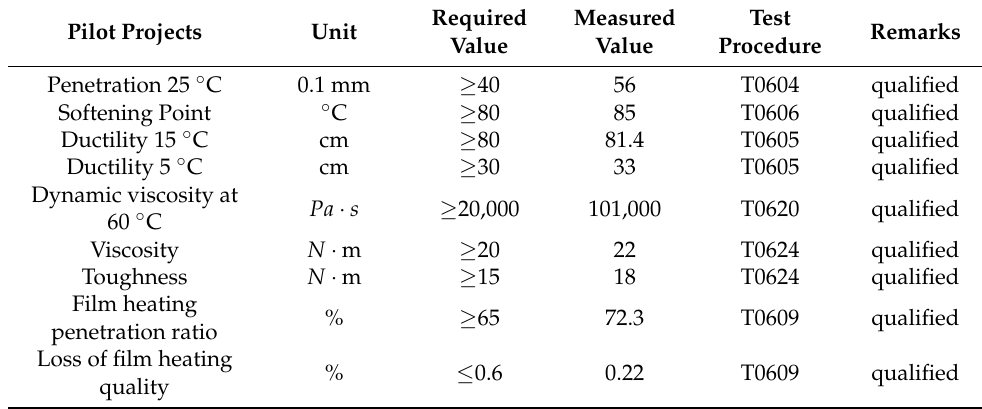
Table 2. Properties and technical requirements of SBS modified